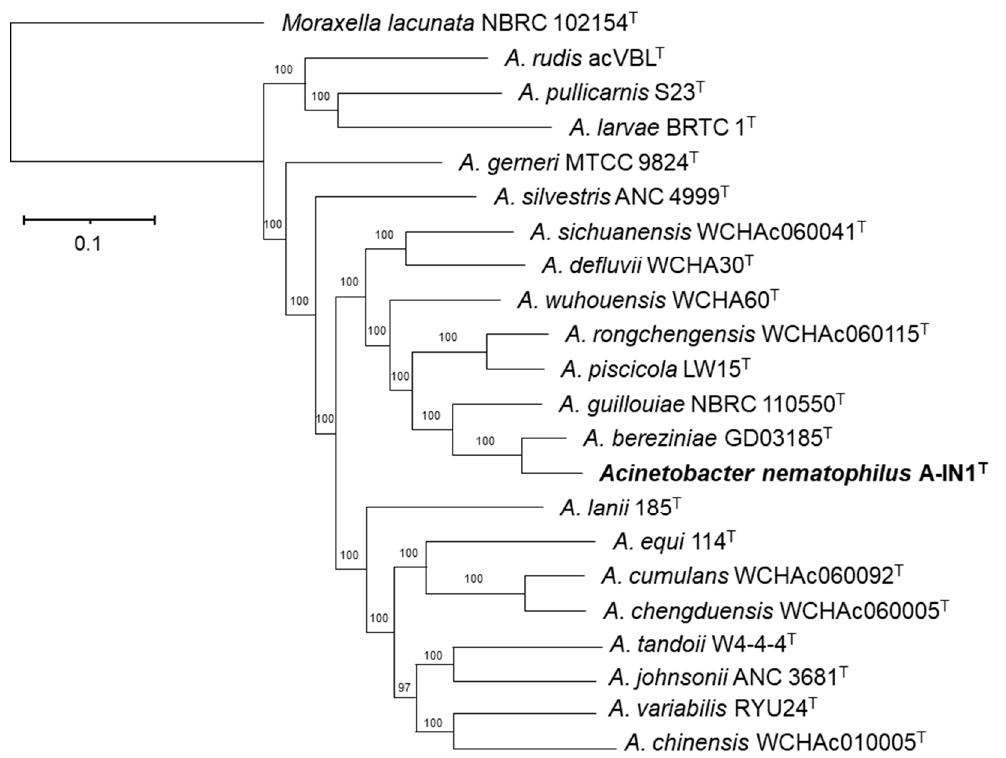
Figure 1. Phylogeny based on core genome sequences of several species of the genus Acinetobacter . 644754 nucleotide positions (601 core genes) were used in the analyses. Numbers at the nodes represent SH-like branch supports. Phylogenomic trees were built using FastTree 2.1.10 based on the Generalized Time Reversible Model (GTR) [61]. Accession numbers of the sequences used in the analyses are shown in Table S1. Bold indicates a novel taxonomic proposal.